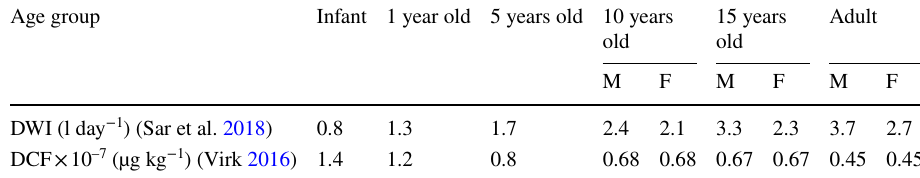
Table 1 Age-dependent dose conversion factors and average daily water